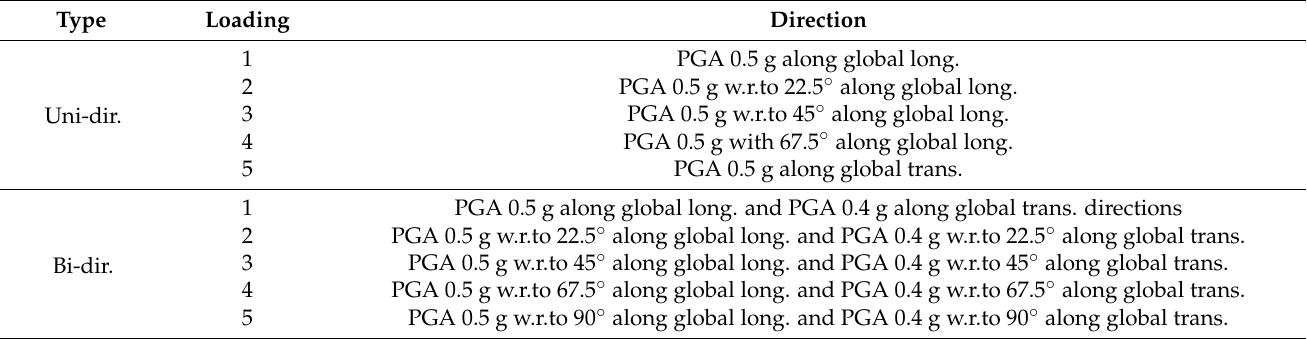
Table A3. Uni-directional and bi-directional loadings considered for Turkey ground